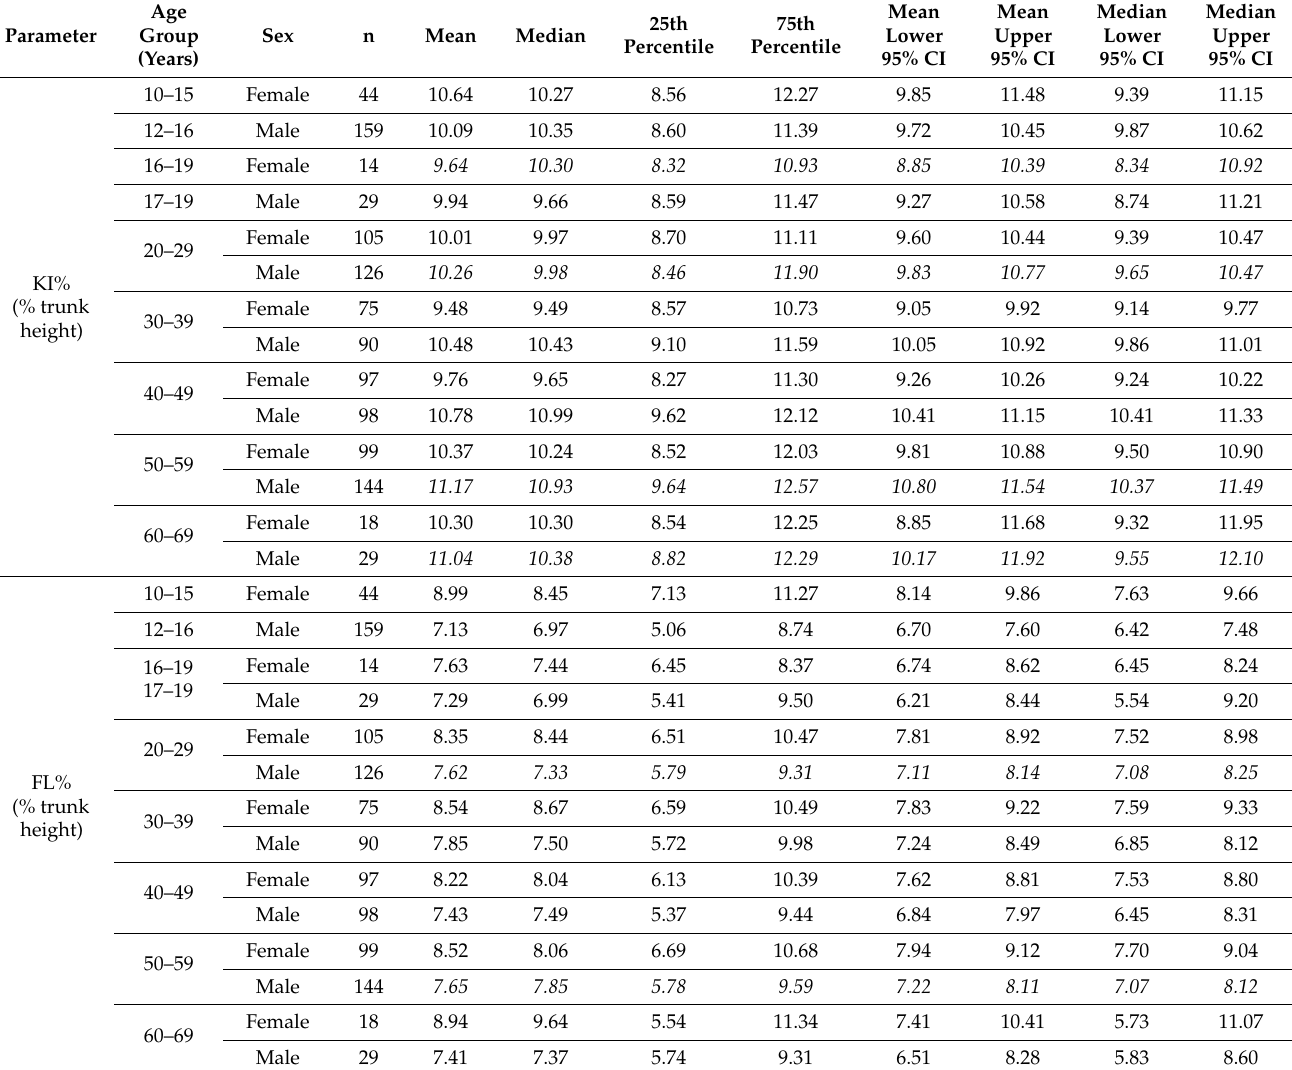
Table 3. Reference data of posture parameters normalized to the trunk height. Non-normally distributed data according to the Kolmogorov–Smirnov test are shown in